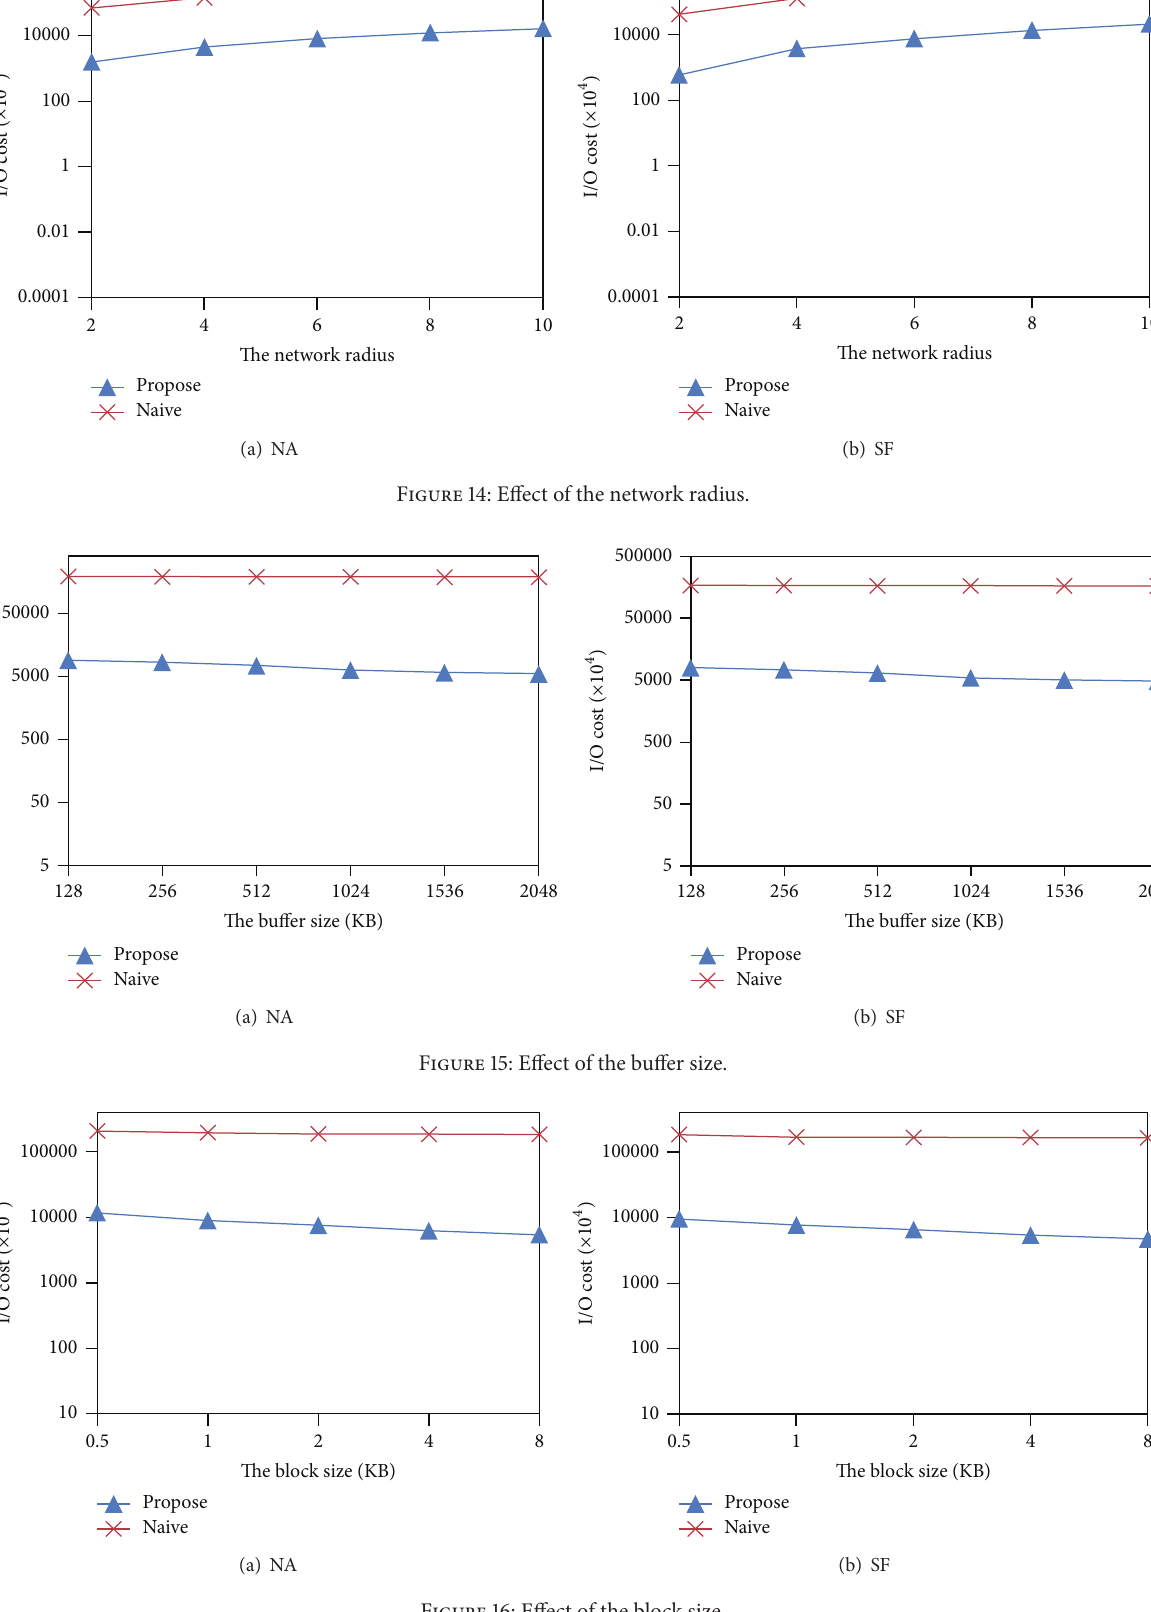
Figure 16: Effect of the block